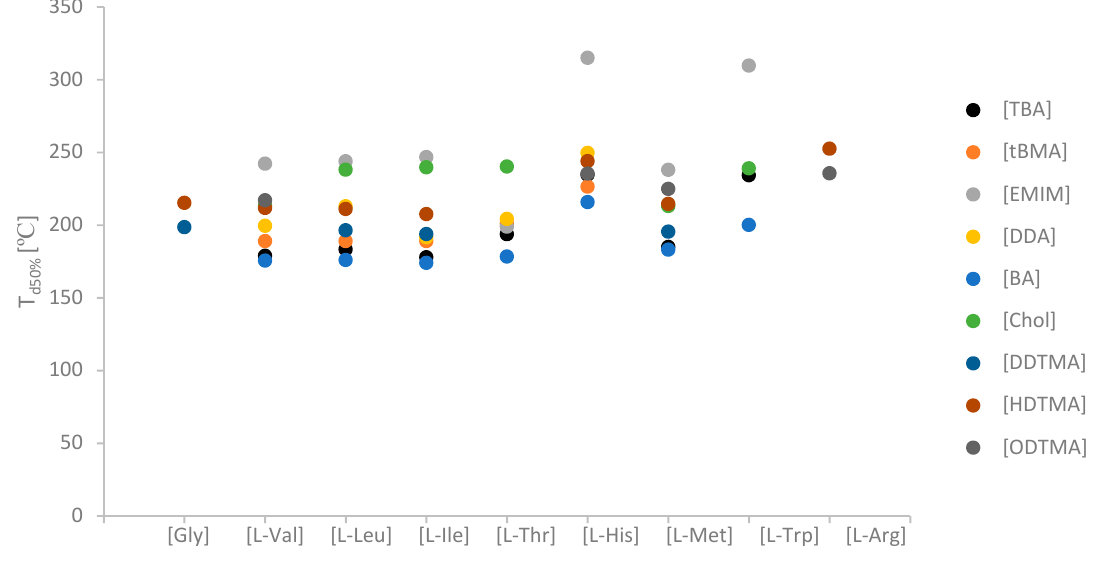
Figure 14. Plot of 50% (T d50% ) weight loss temperature vs. amino acids.